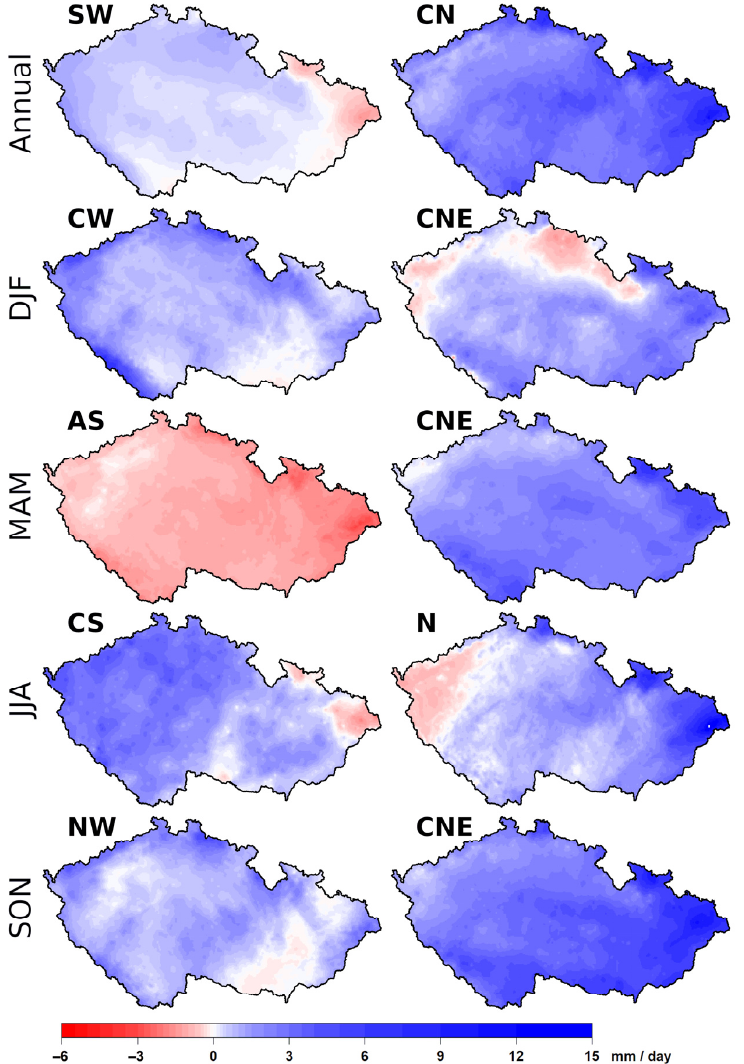
Figure 12. Anomalies of the annual and seasonal daily mean precipitation (the 1961–2020 reference period) for the circulation types under the objective classification with the largest difference in the daily mean precipitation favoring BOH ( left column ) and M&S ( right column ). Included types: SW, directional southwestern; CN, cyclonic northern; CW, cyclonic western; CNE, cyclonic northeastern; AS, anticyclonic southern; N, directional northern; NW, directional northwestern.